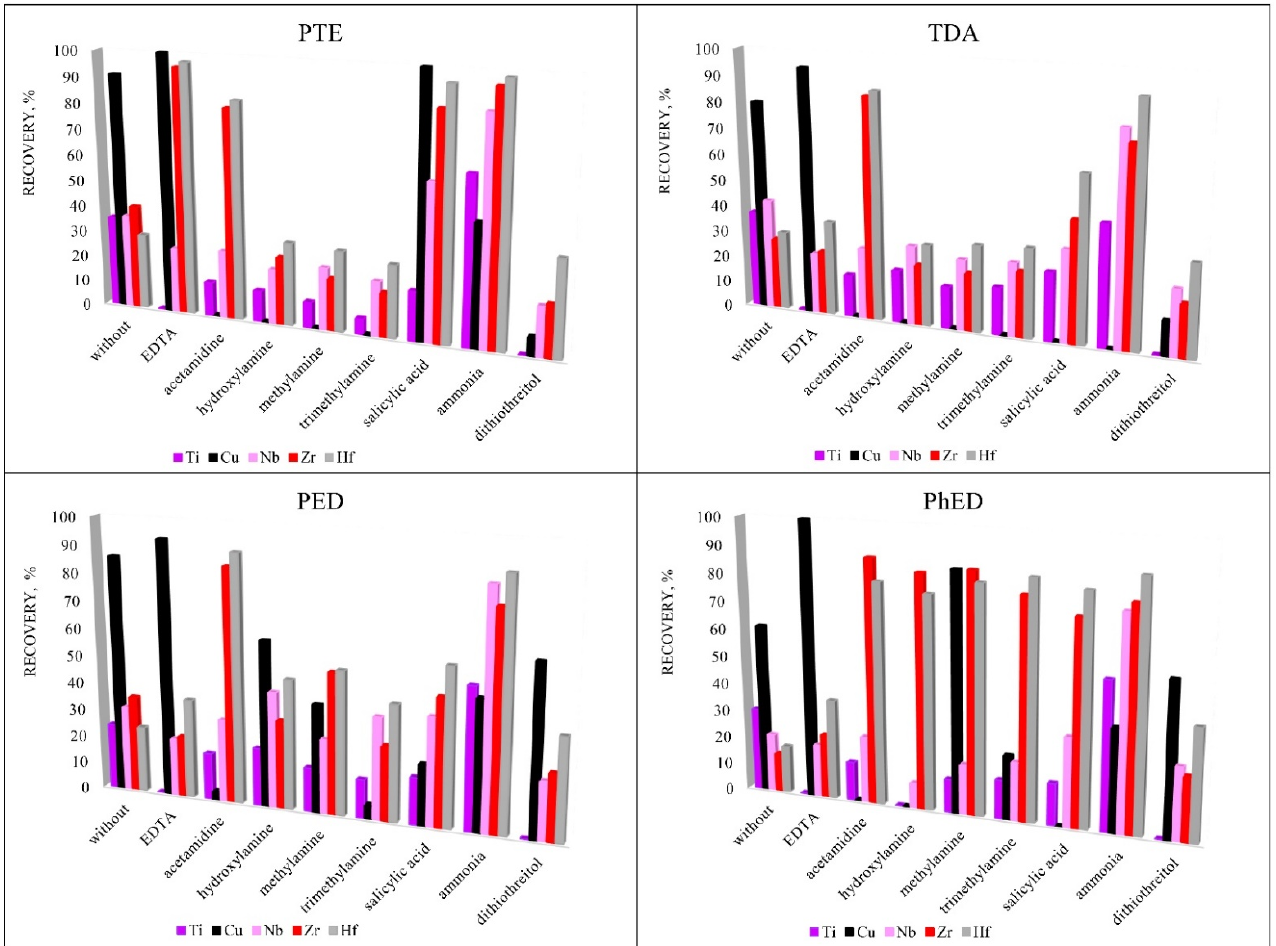
Figure 5. The influence of additional reagents on recovery. Sorption conditions: 0.1 mol/L HCl, c additional reagents = 5 mg/L, m sorbent = 0.1 g, V liquid phase = 10 mL, t = 1 h, T = 60 °C, C analytes = 1 mg/L. The proposed mechanism of reaction with EDTA (a) and ammonia (b) is shown in Figure 6. The metal atom forms a more stable complex with sulphur atoms than the nitrogen atom in the sorbent and additional